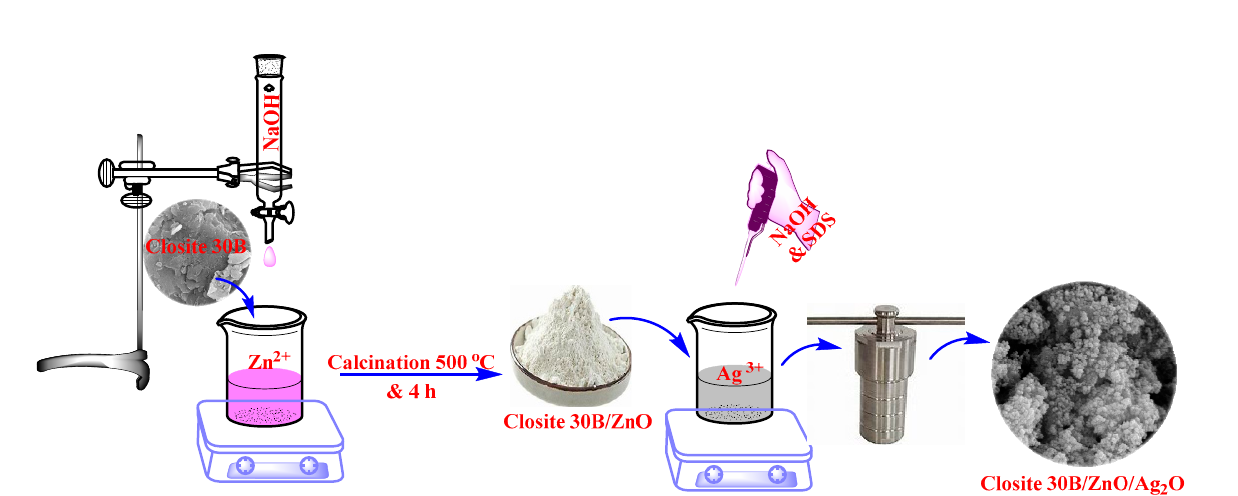
Figure 1. Schematic view of Cloisite 30B/ZnO/Ag 2 O photocatalyst synthesis process.